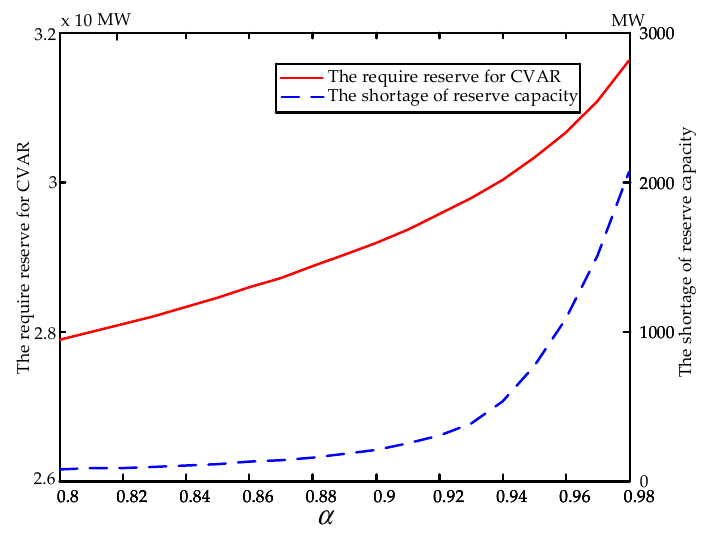
(d) C4 Figure 9. The shortage of reserve capacities for the different cases presented.